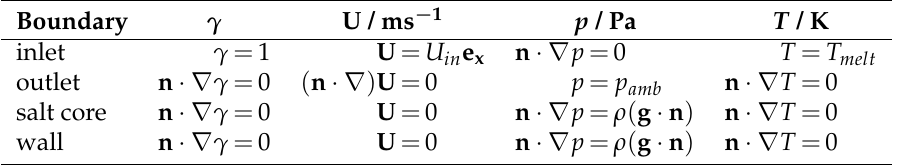
Figure 1. The geometry for investigating the slamming on a salt core in channel; all dimensions are in mm. Table 1. Boundary conditions for the presented model. n denotes the outward unit normal